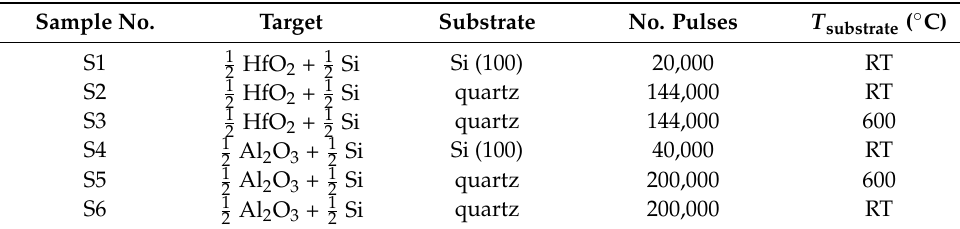
Table 1. Deposition conditions to obtain silicates as thin films by PLD. Sample No.